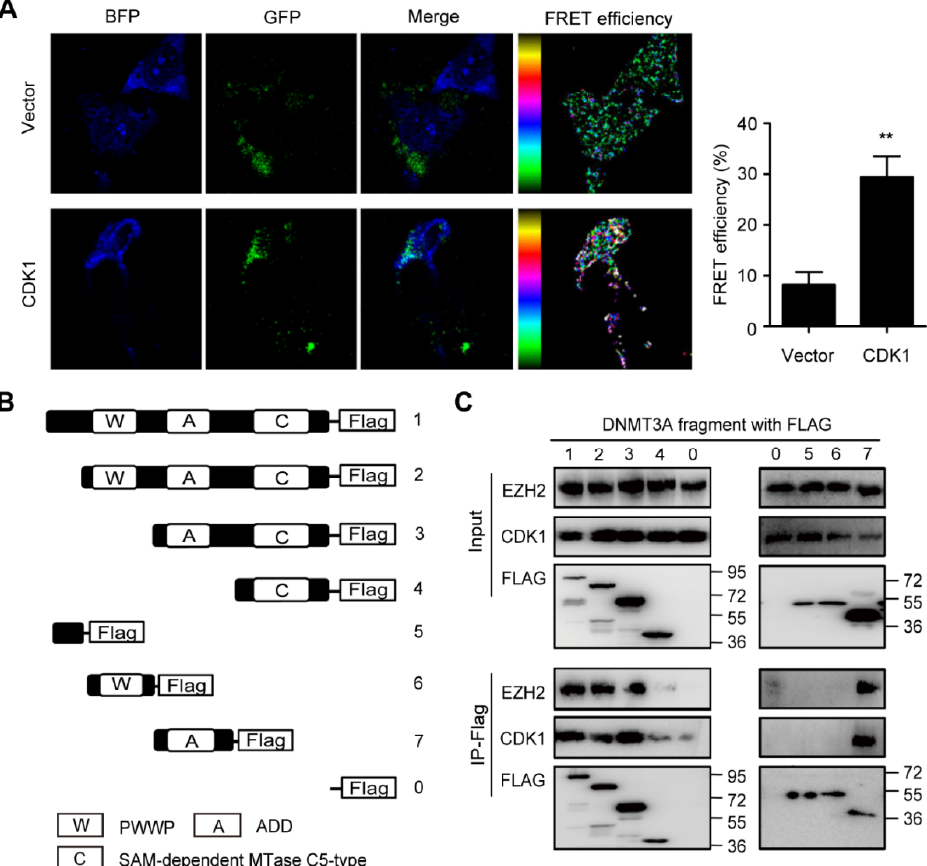
Figure 1. ADD domain of DNMT3A is responsible for the interaction between DNMT3A and CDK1. ( A ) NIH3T3 cells expressed Vector-GFP, CDK1-GFP (green), and DNMT3A-BFP (blue) as indicated. The merged picture reveals the colocalization of CDK1 and DNMT3A proteins. The fluorescence resonance energy transfer (FRET) analysis demonstrated that the FRET efficiency increased more in the CDK1 group than in the vector group. ( B ) Truncated DNMT3A plasmids were constructed by editing PWWP, ADD, and SAM-dependent MTase C5-type domains as indicated. ( C ) Co-immunoprecipitation of CDK1, EZH2, and truncated DNMT3A/wild-type DNMT3A proteins as indicated. Data are presented as mean ± SD, ** p < 0.01.